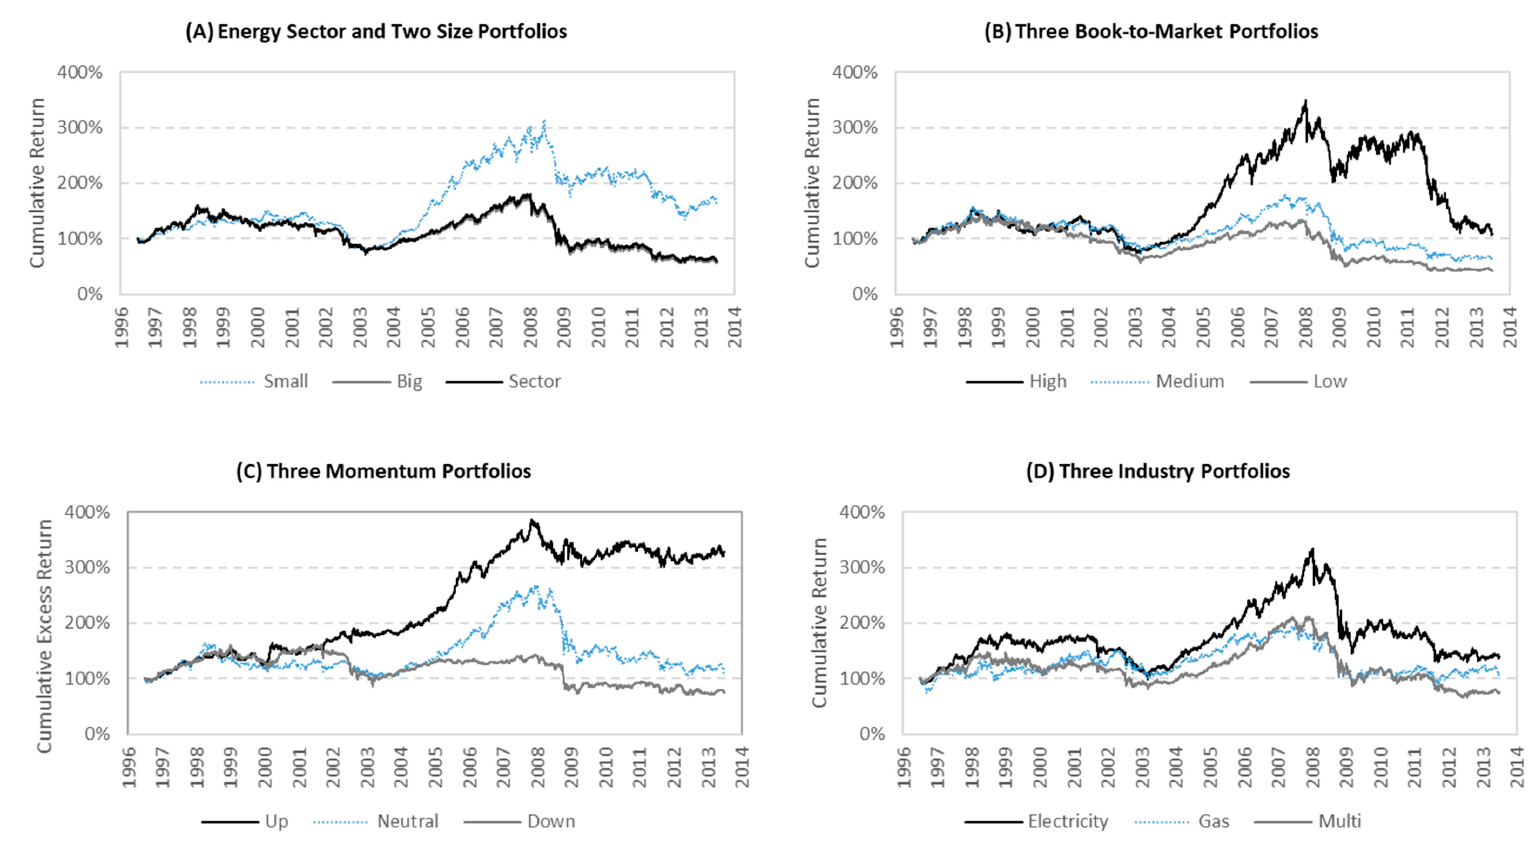
Figure 1. Cumulative return for the 12 energy portfolios. This figure presents the cumulative return profile of the 12 energy utility portfolios constructed. Plot ( A ) contains the whole energy sector, small utilities and big utilities. Plot ( B ) contains the three portfolios formed on book-to-market: high-, mid- and low-BE/ME. The portfolios represent value, neutral and growth stocks, respectively. Plot ( C ) contains the three momentum portfolios: up, neutral and down momentum. Plot ( D ) contains the three industry portfolios: electricity-, natural gas- and multi-utility.